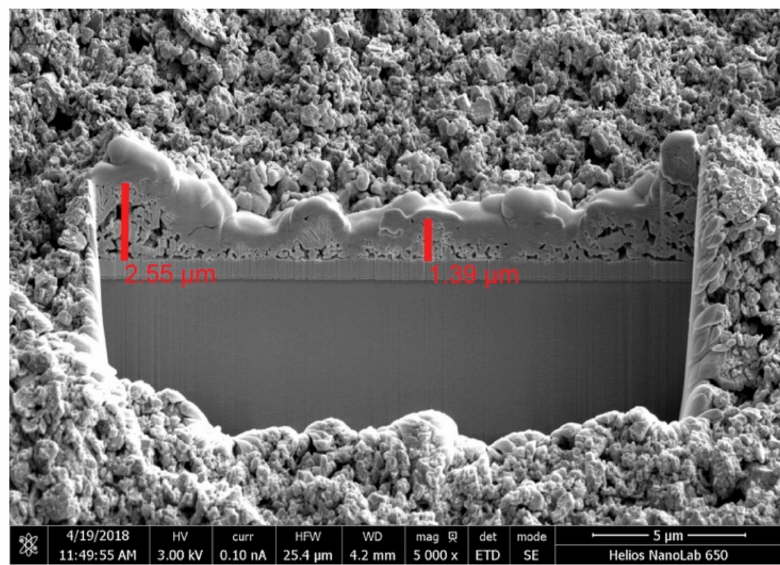
Figure 4. Fast ion bombardment (FIB) image of an NiO electrode. A platinum layer was sputtered onto the top surface as a protective layer, and a gallium beam (30 kV) was used to cut into the NiO. The depths of the NiO layer at two points (2.55 and 1.30 µ m) are marked in red.